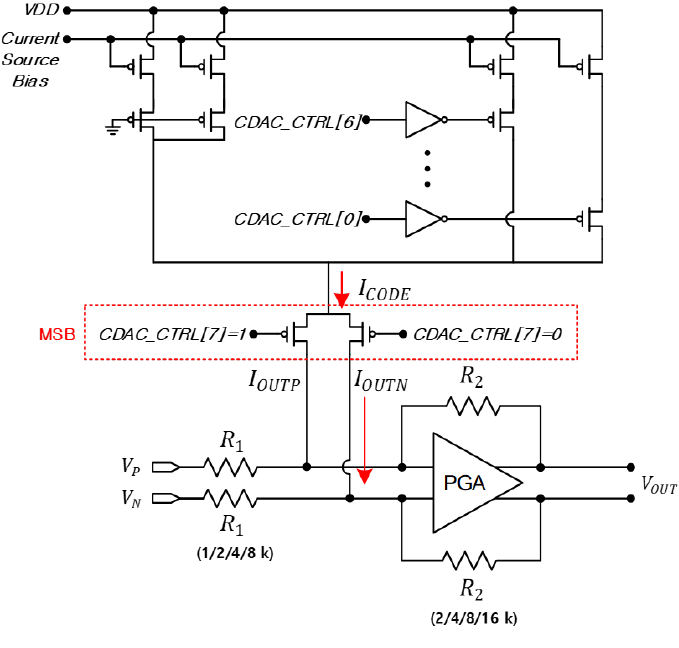
Figure 7. CDAC circuit